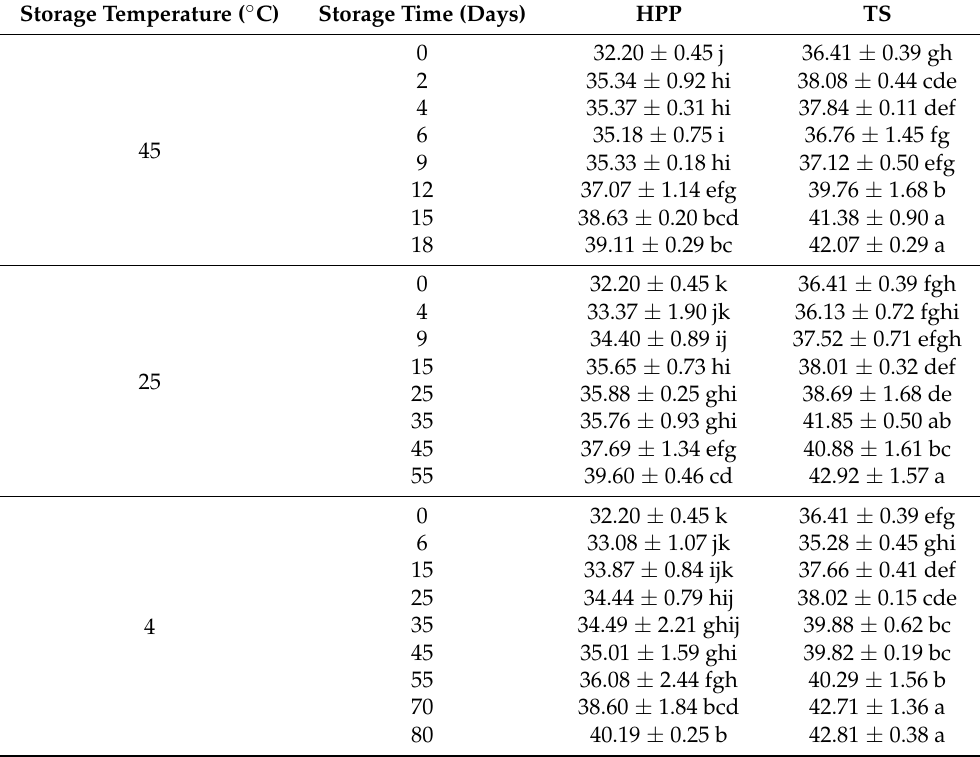
Table 3. Changes in total color difference of HPP and TS marinated lotus root slices during storage.